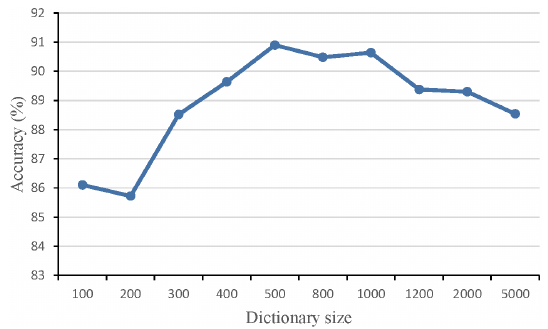
Figure 9. The curve of overall accuracy of BoMS with different dictionary